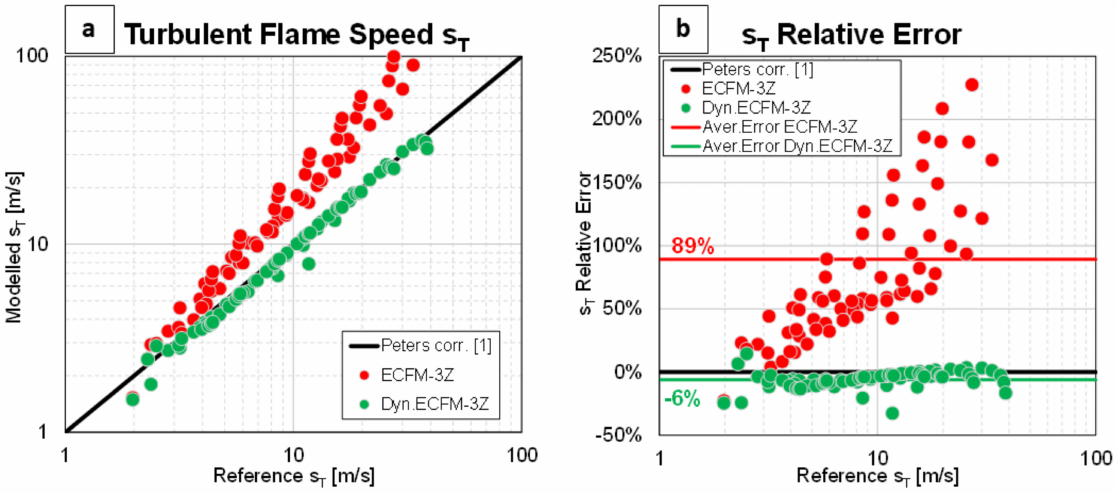
Figure 9. ( a ) Comparison of modelled against reference turbulent flame speed s T ; ( b ) relative percentage error between modelled and reference turbulent flame speed s T . In both graphs, a logarithmic scale is used for s T ( x -axis) to clearly show low and high s T